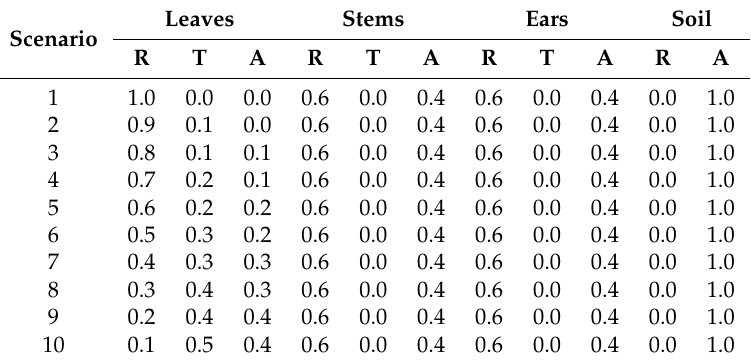
Table 2. Varying artificial optical properties. With R for reflectance, T for transmittance and A for absorptance